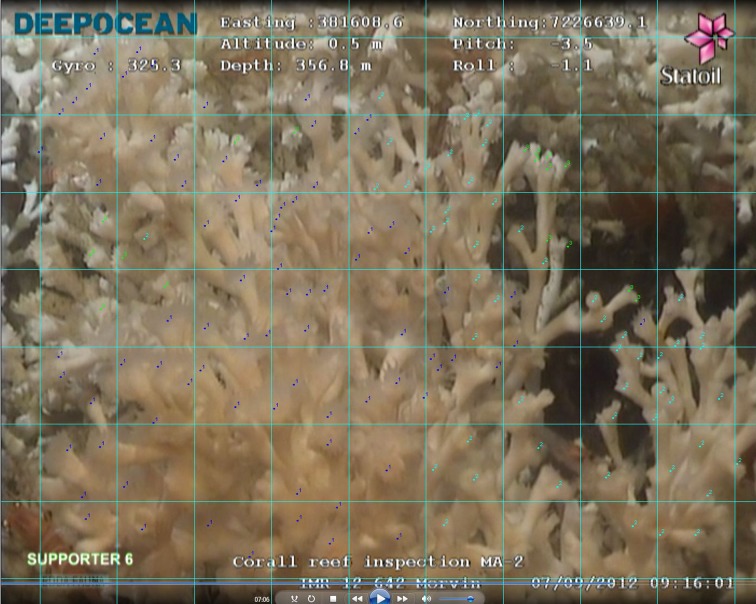

Lophelia pertusa tentacle extension state.1) Dark blue numbered dots indicate fully extended tentacles, 2) Light blue numbered dots indicate visible, but not extended tentacles, 3) Green numbered dots indicate coral cups with no polyp tentacles visible.